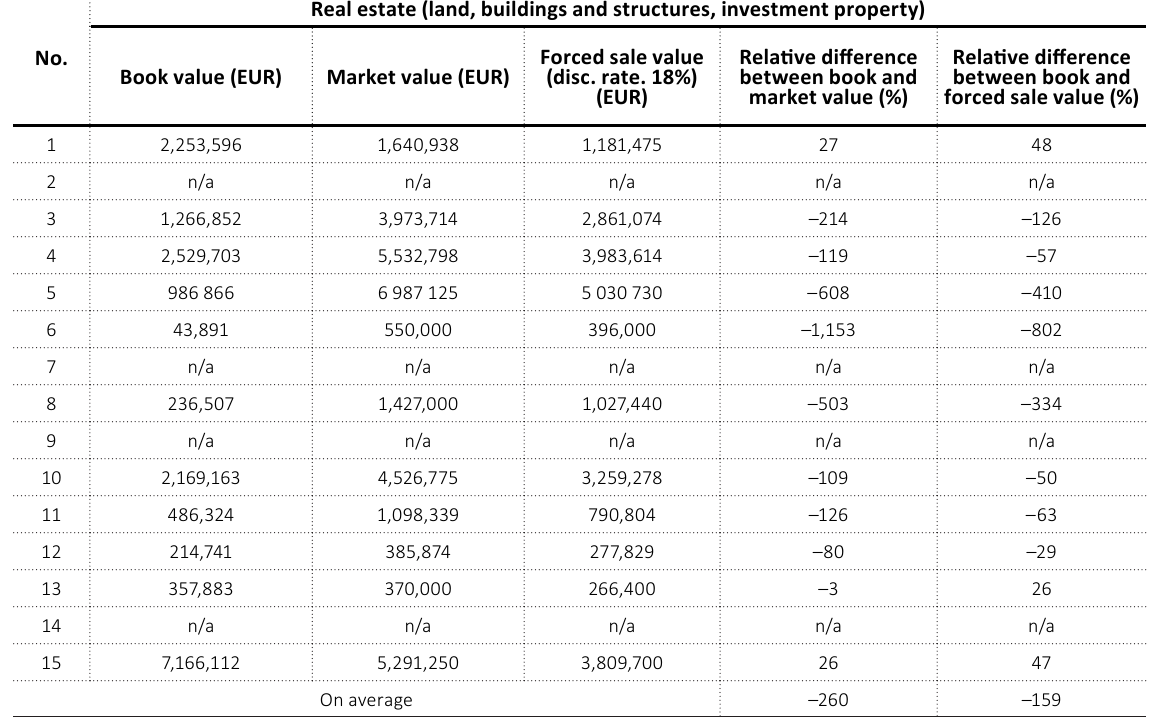
Source: Own data.